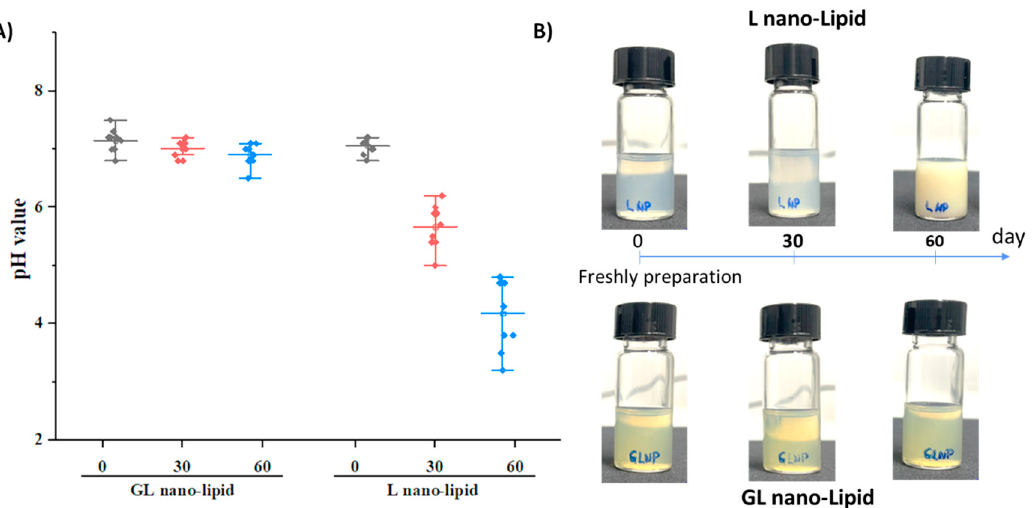
Figure 4. pH value ( A ) and visual observations (B) of GL nano-lipid and L-nano-lipid solutions during storage time: 0 day, 30 days and 60 days at 25 ◦ C. Boxes represent pH value with a probability between 25% and 75%; the line inside the box indicates the median pH value of solution, and bullets indicate data.